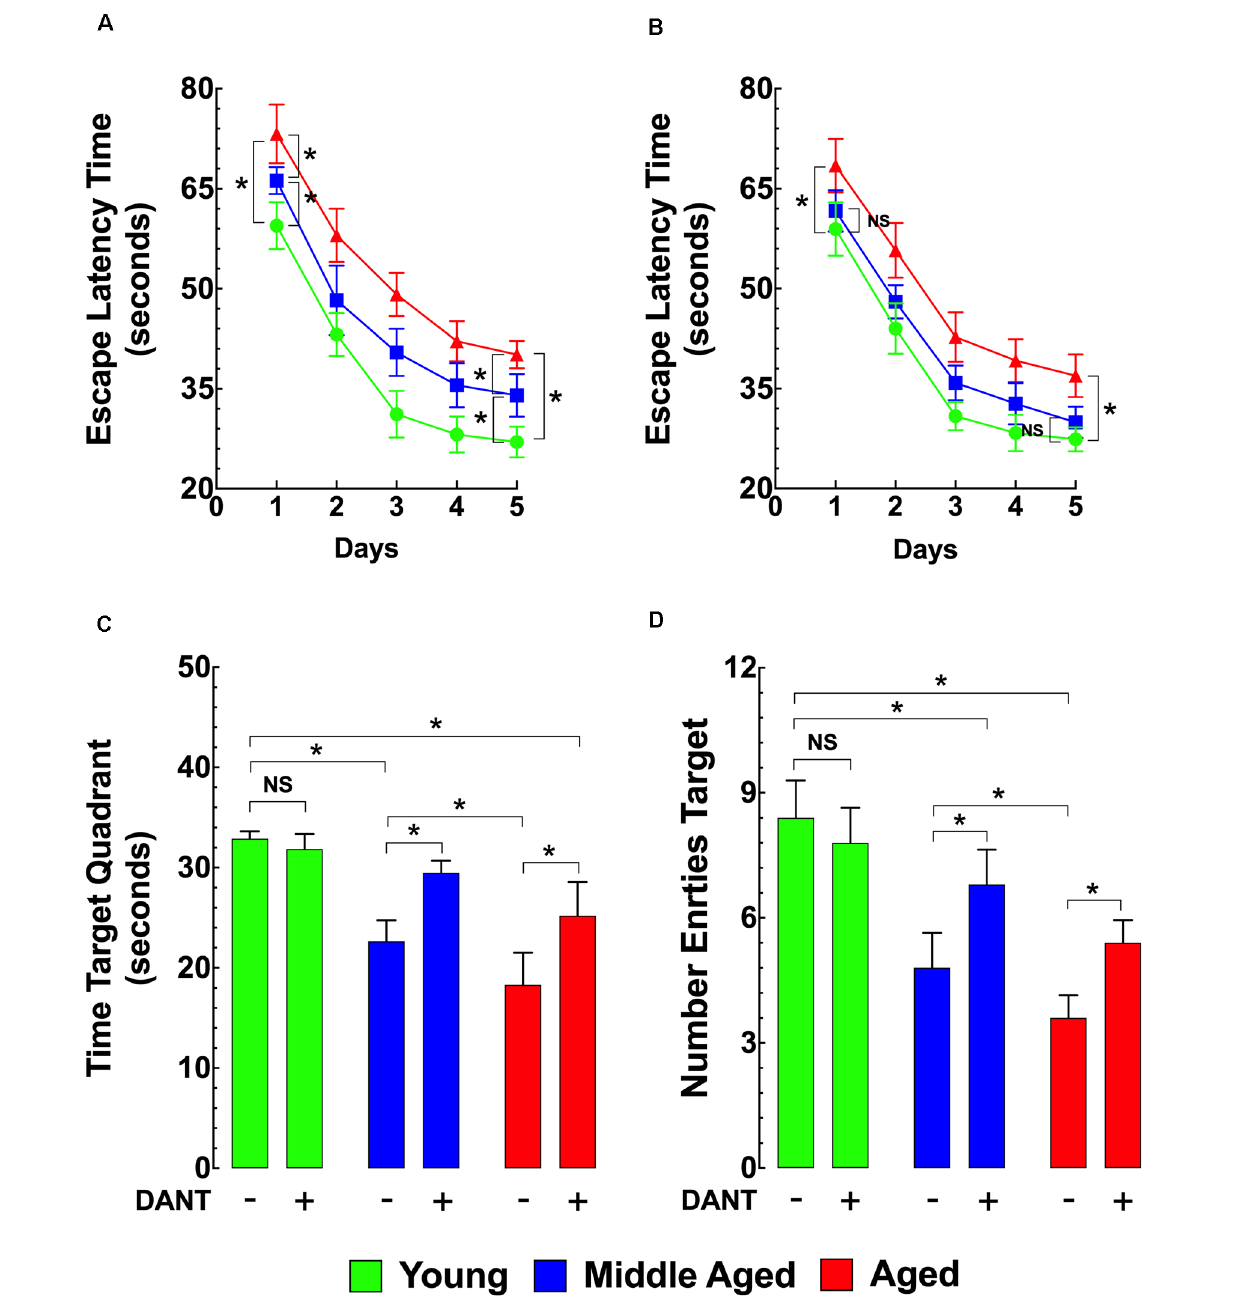
FIGURE 4 | Effects of aging on cognitive function. Effects of dantrolene. The Morris water maze (MWM) was used to assess spatial learning and memory in young, middle-aged, and aged mice. Middle-aged and aged mice showed a reduced escape latency time (ELT; A ), a time in the target quadrant (C) , and the number of entries into the target quadrant (D) compared to young mice. Dantrolene (1 mg/kg, i.p) for 5 days. before and during the training period (TP), and probe trial (PT) periods improved all of the parameters studied (B–D) . On the horizontal axis of panels (C,D) are indicated the experimental conditions. Values are expressed as mean ± SEM from n mice = 10 per age group. One-way ANOVA followed by Tukey’s post hoc comparisons, * p ≤ 0.05; NS, not